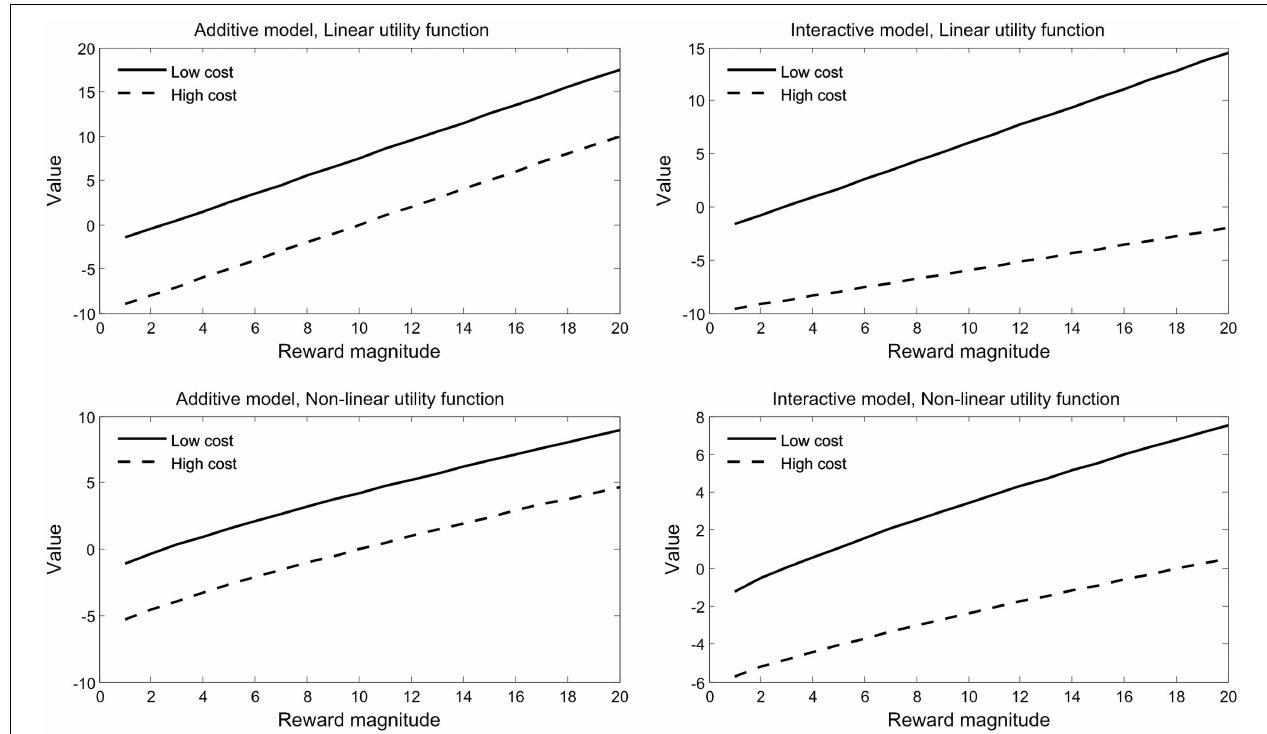
rewards and costs (those that were employed byTalmi et al., 2009); bottom panels employed a power function with exponent 0.8. Additive models with non-linear utility (bottom left) represent the predictions of expected utility theory with p = 1. Figure adapted from Park et al.